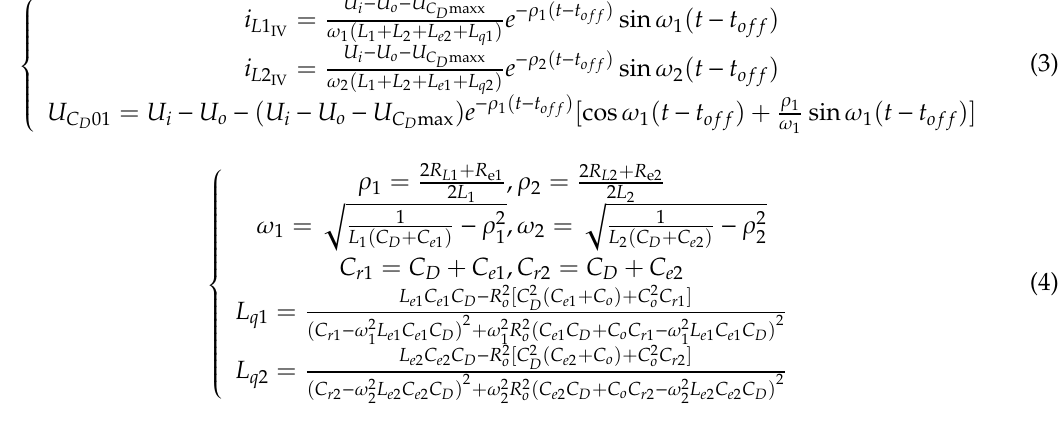
Figure 7. Equivalent circuit of Sneak Mode 1.